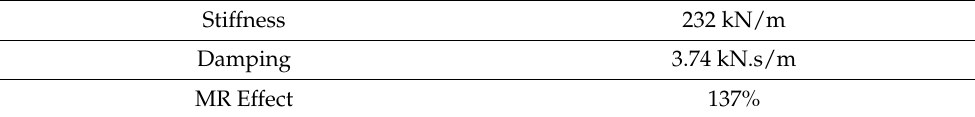
Table 2. Base isolation parameters.